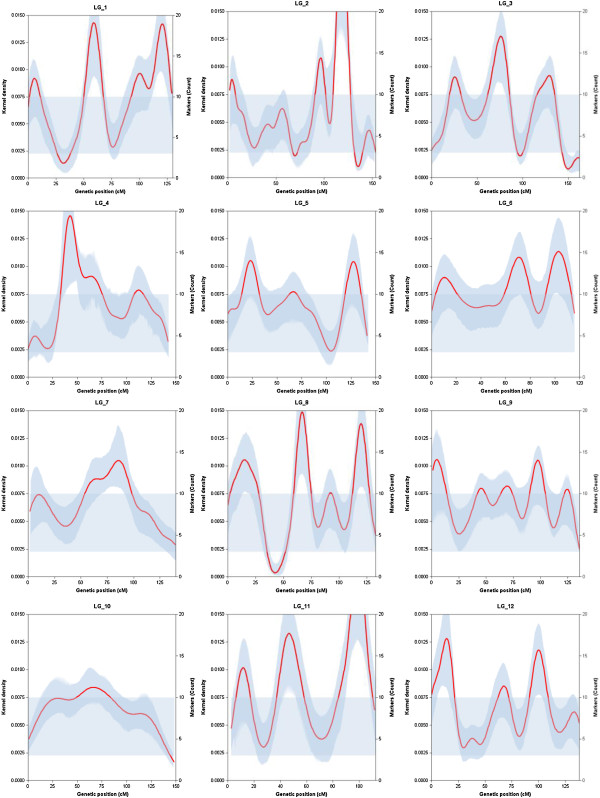
Kernel density estimators (left y-axis) of marker density (right y-axis) along each linkage group (x-axis in cM). The red curve corresponds to the kernel density estimator. The surrounding bandplot (in dark blue) is the confidence interval of the kernel density estimator. The horizontal bandplot (in light blue) is the range of variation of marker density under a Poisson distribution. When the lower or upper limit of the confidence interval is above or below this range, we declare the presence of a significant cold or hot spot of recombination, respectively.